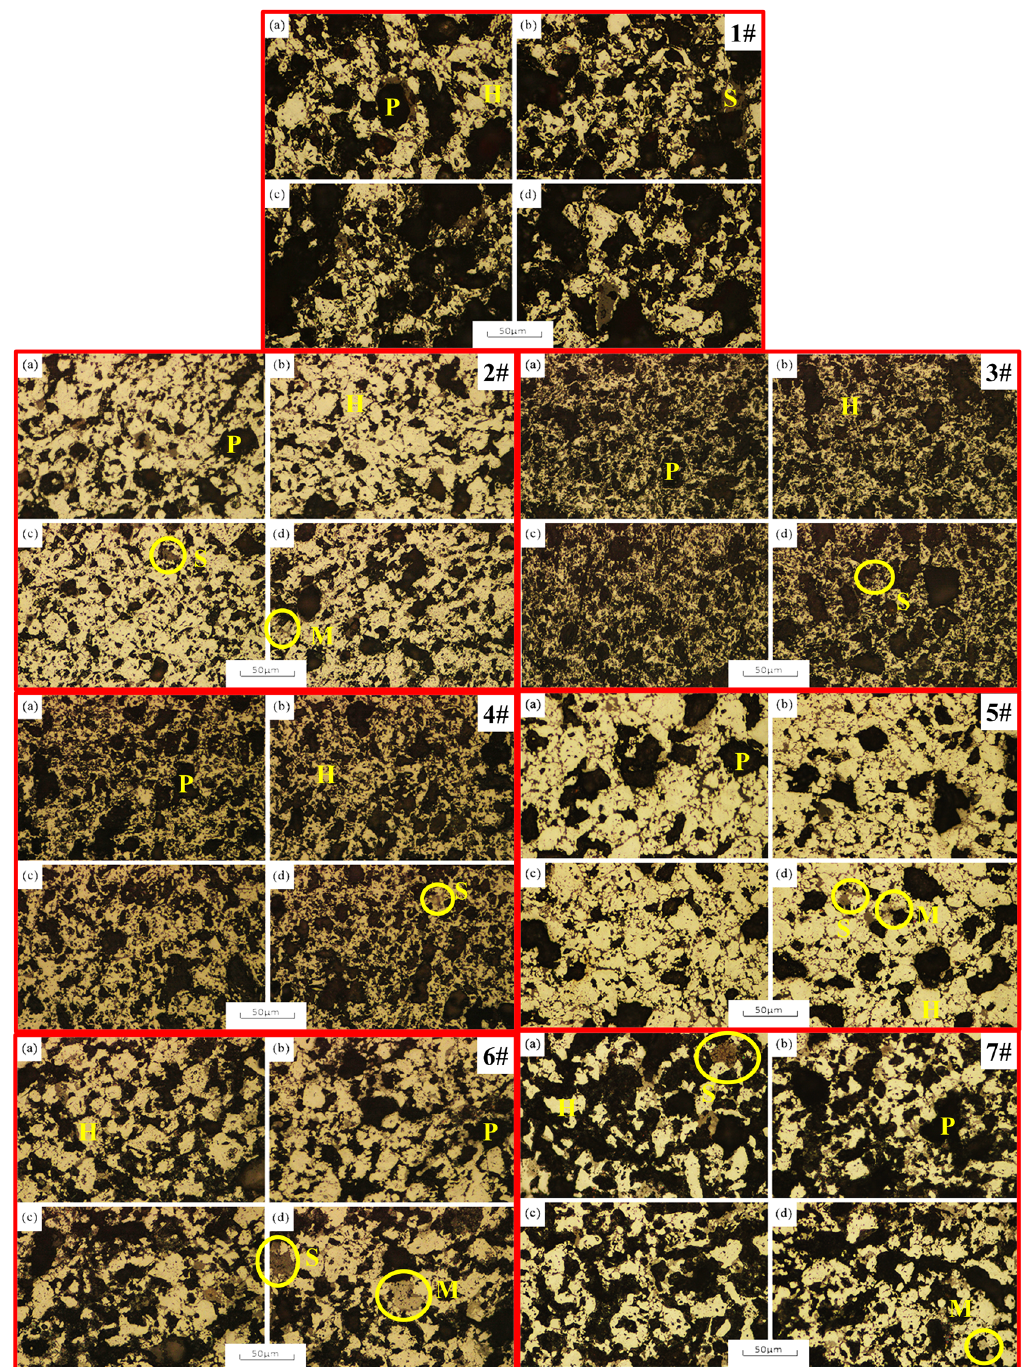
Figure 5. Mineral phase diagram of sample with different basicity. H—hematite; M—magnetite; S—liquid phase; P—porosity. Table 6. Generation of each phase of roasted pellets with different basicity/% .